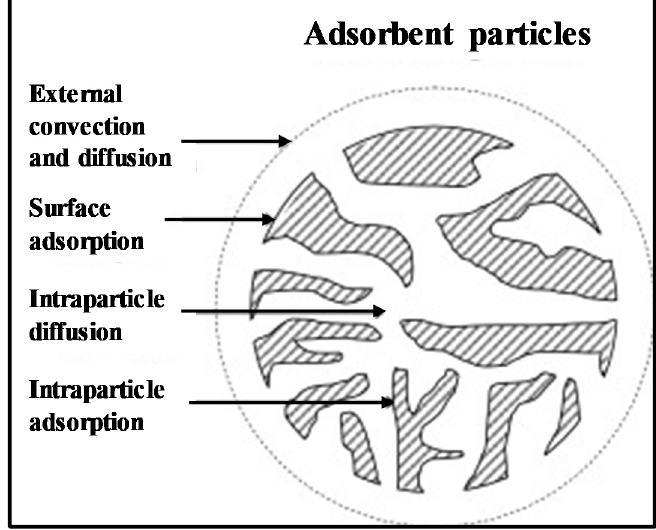
Figure 11. The illustration of the relationship between particle size, membrane compactness, water permeability, and ammonia rejection (adsorption).